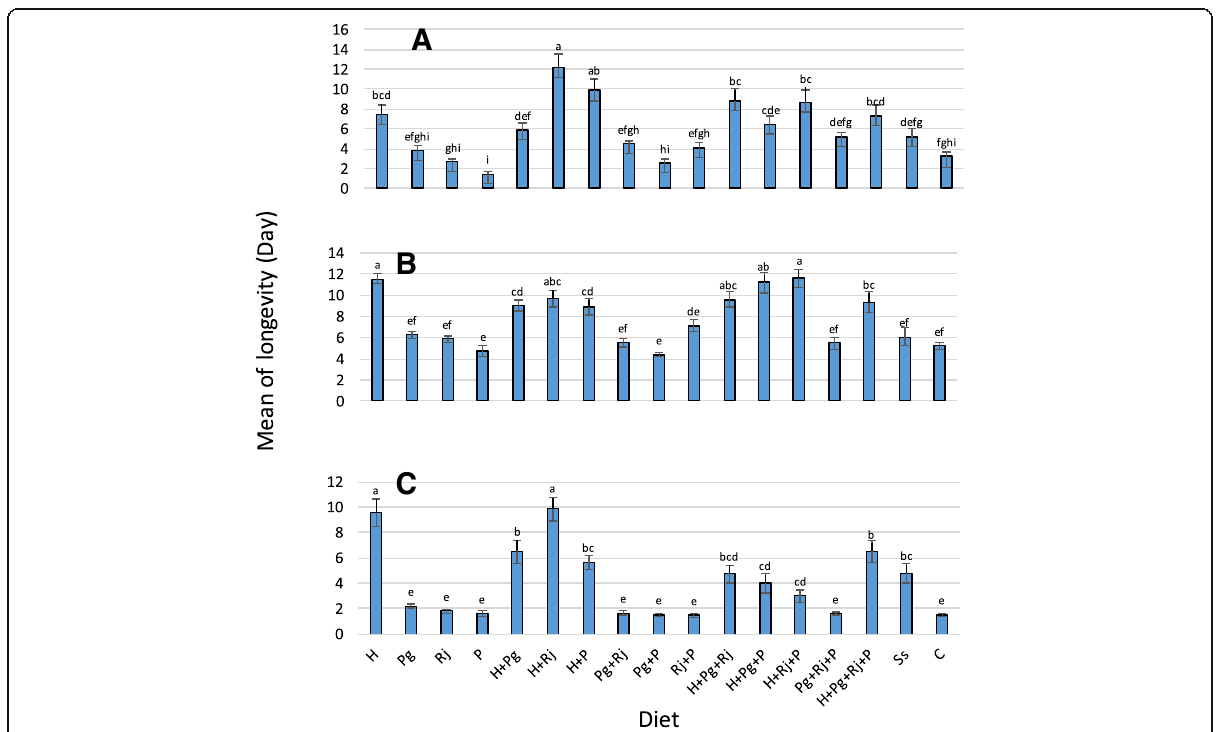
Fig. 1 Mean longevity of a T.evanescens , b T. bourarachae , and c T . cacoeciae supplied with different diets and the control